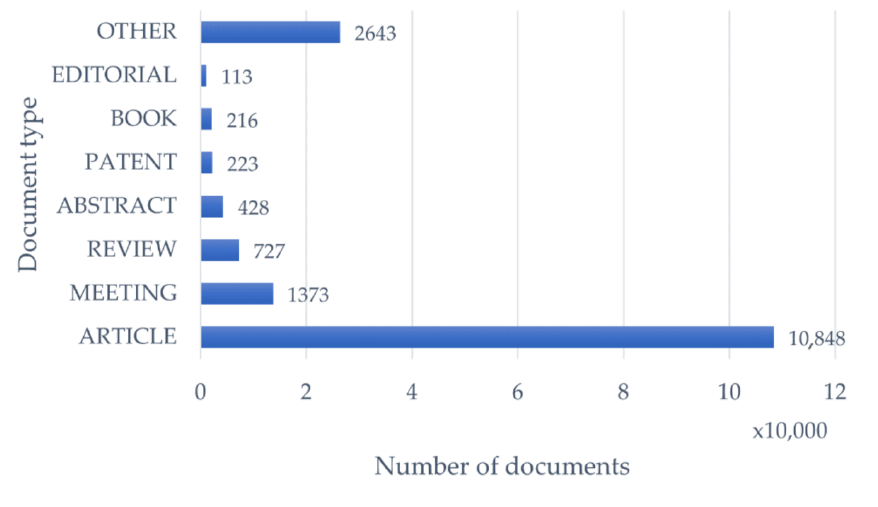
Figure 5. The most frequently used document type in the research documents on ozone in the plant